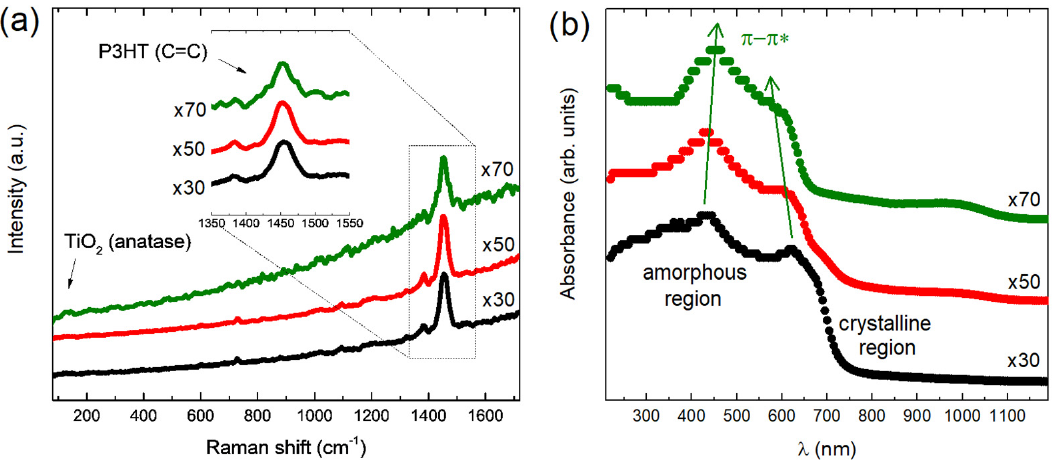
Figure 3. ( a ) microRaman spectra and ( b ) UV-Vis absorbance spectra collected in reflectance mode for ×30, ×50 and ×70 nanocompostites.